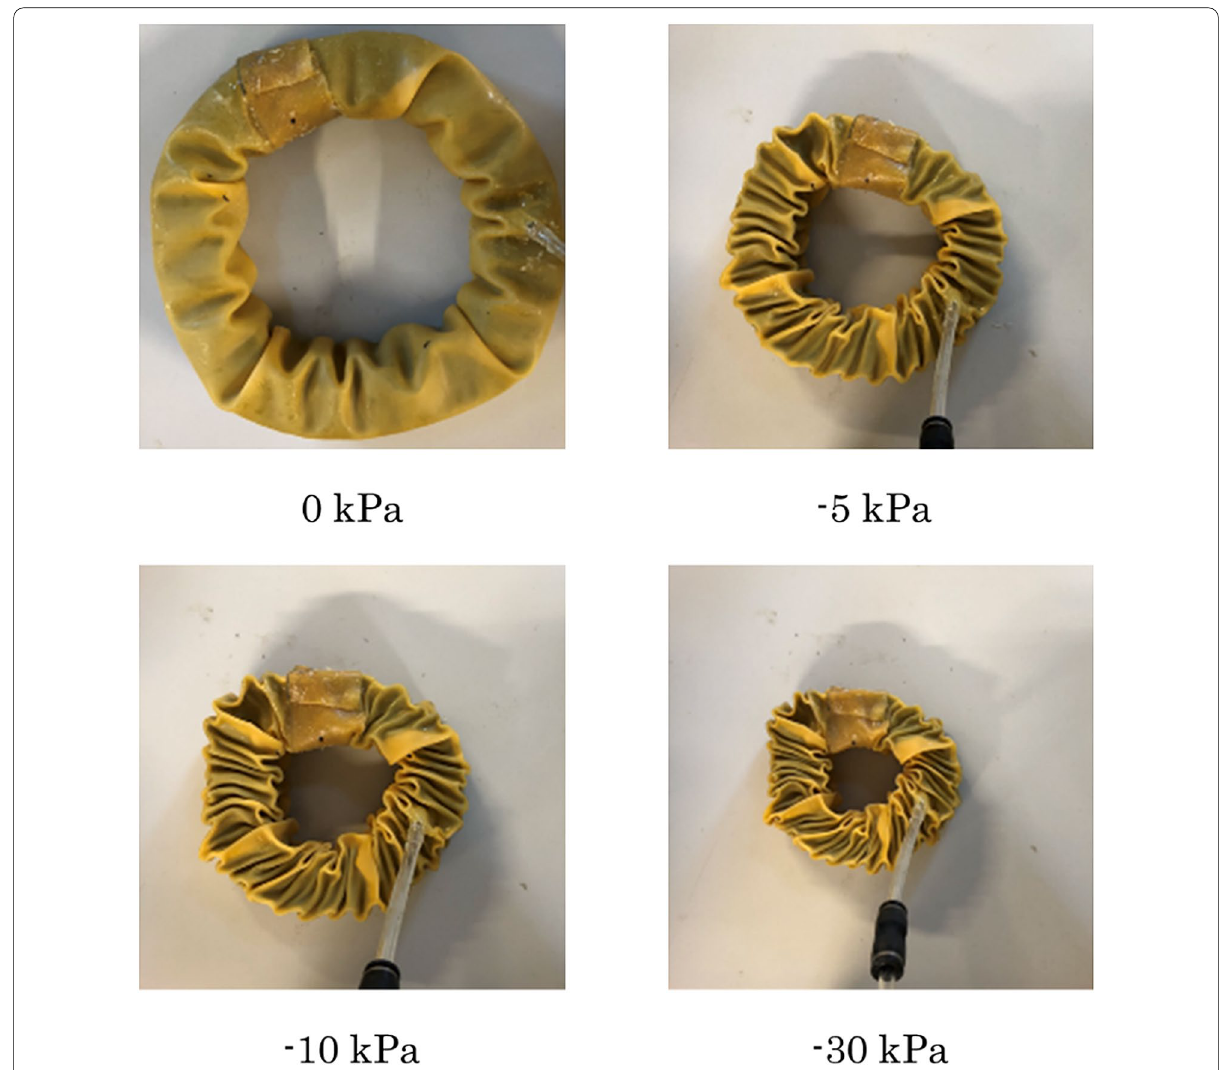
Fig. 7 Deformations of a rubber band gripper at various vacuum pressures (0, at the low vacuum pressure ( nearly a minimum